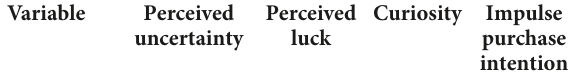
TABLE 4 Discriminant validity test of